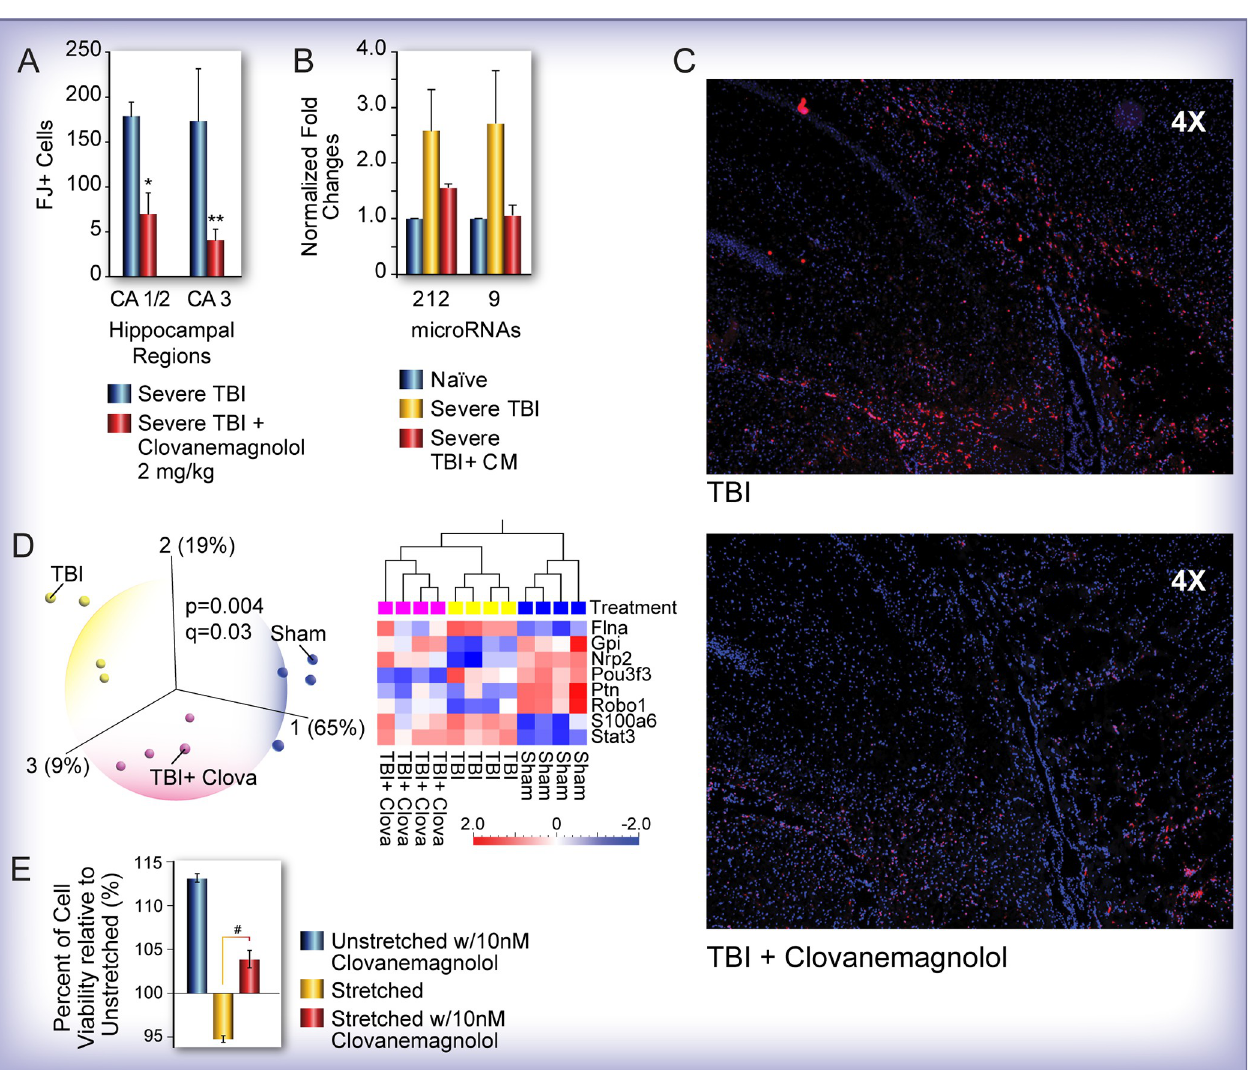
Fig 3. Characterization of the neuroprotective effects of clovanemagnolol (CM) in vivo and in vitro . (A) Stereological counting of dying/injured Fluoro- Jade-positive (FJ+) pyramidal hippocampal neurons in TBI and TBI+CM rats showed that CM treatment significantly reduced neuronal injury in the CA1/2 ( � p < 0.02) and CA3 ( �� p < 0.04) regions. (B) Quantitative real-time RT-PCR analysis of microRNA expression in the CA1-CA3 hippocampal subregions showed that CM treatment appeared to restore expression of miR-212 and miR-9 to na ï ve control levels. Results did not reach statistical significance. (C) Immunofluorescent staining of relative microglial activation (anti-CD11b) between TBI and TBI + CM-treated rats. The images show the hippocampal formation and surrounding regions. (D) Gene expression data from the RT profiler Neurogenesis PCR arrays (n = 4/group) were analyzed using bioinformatic software (Qlucore Omics Explorer). Principal component and hierarchical clustering heatmap analysis of significantly expressed genes (p = 0.004, q = 0.03) in the hippocampus of sham control, TBI and TBI+CM rats shows that eight genes can clearly discriminate the three groups from each other. Two genes (Gpi and Nrp2) that are restored to sham control levels by CM are associated with pro-survival roles in the brain. (E) H19-7 cells treated with 10nM CM 48 hours pre- injury were stretched at 50 msec, 30psi. A significant increase in cell viability of the drug treated stretched cells compared with stretched cells was shown by an MTS assay 24 hours after injury (#p < 0.05). All error bars in A, B and E are SEM, standard error of the mean.